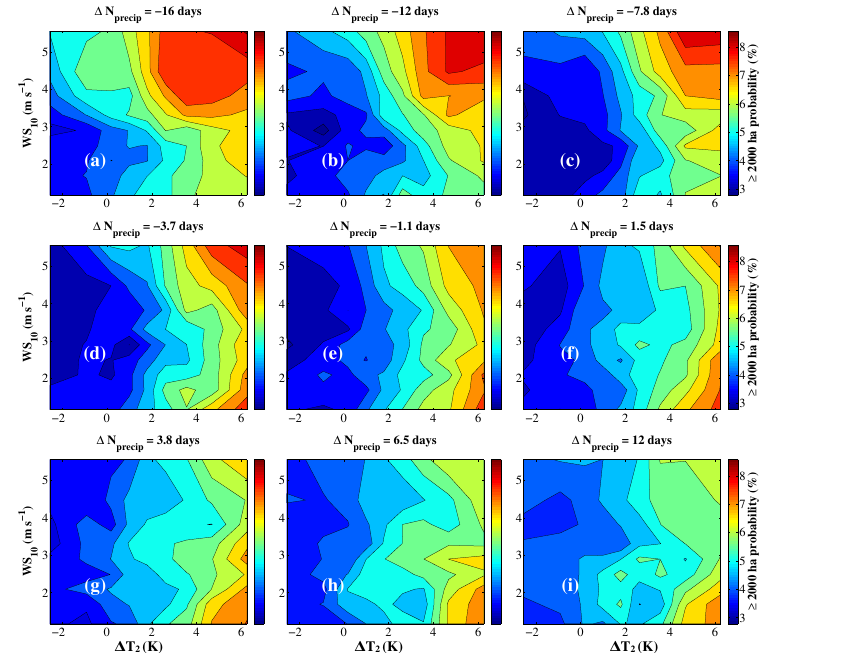
Figure 3. Estimated probabilities of fire size (BA) exceeding the 2000ha threshold (BA M data set). The x axis is the 2m air temperature anomaly ( (cid:49)T 2 ), the y axis the 10m wind speed (WS 10 ) and each panel stands for values of January–June precipitation days anomaly ( (cid:49)N precip ) centred on the given value on the panel titles.